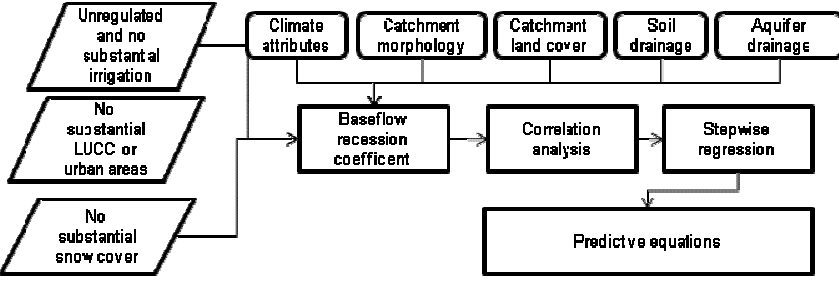
Fig. 1. Methodology flowchart. Unregulated catchments without substantial land use and land cover change (LUCC) and with snow, irrigation or urban extent < 5% are selected for the analysis. Streamflow had to have at least 5 years of data , 30 runoff events and 30 Q – Q ∗ data pairs.